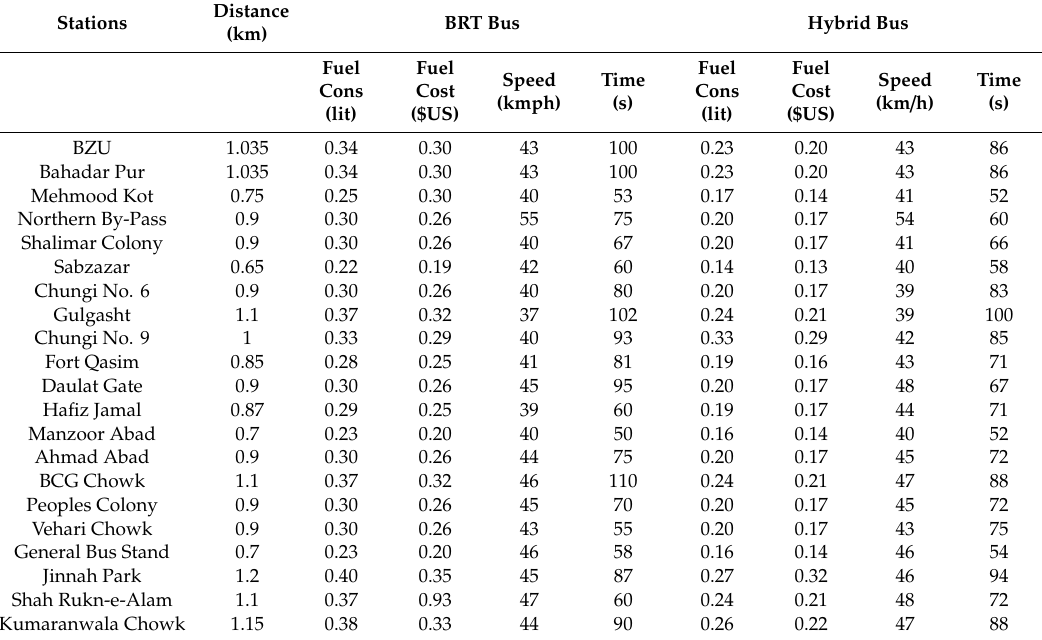
Table 1. Fuel Consumption and Comparative Route Performance